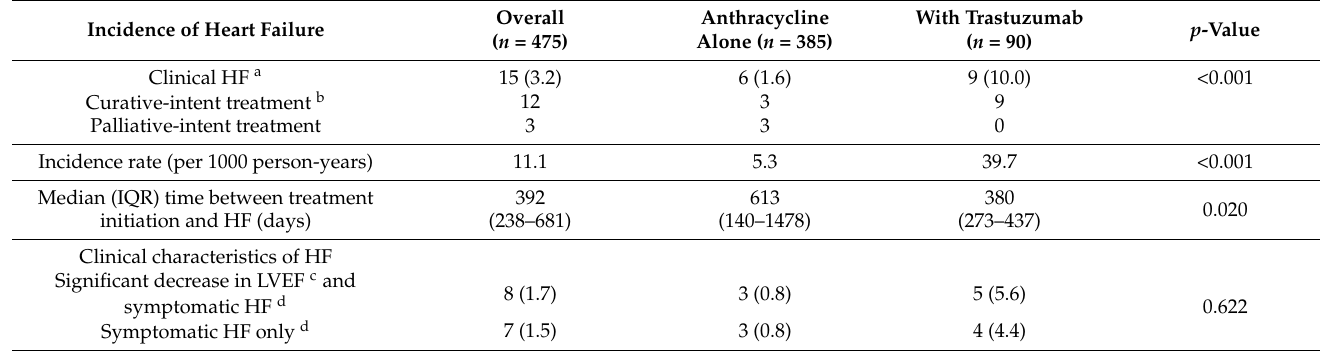
Table 2. Incidence of heart failure ( n =